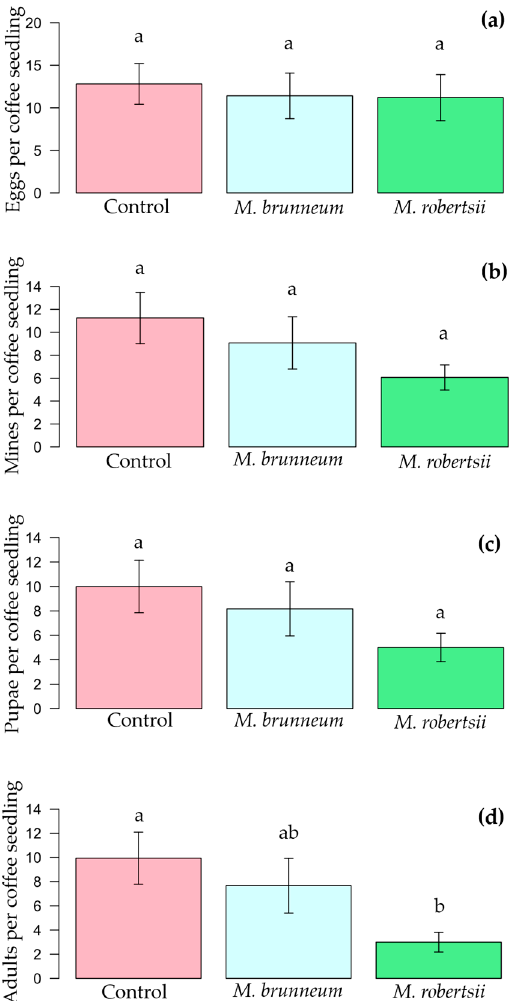
Figure 4. Development of Leucoptera coffeella in coffee seedlings with Metarhizium robertsii and Metarhizium brunneum inoculation by soil drench. ( a ) Number of eggs; ( b ) number of mines; ( c ) number of pupae; ( d ) number of adults. Inoculation of 30 mL of each isolate suspension was to the surface of the soil in each coffee seedling while the control received a sterile solution of Tween 0.05%. Bars with the same letters are not statistically different.